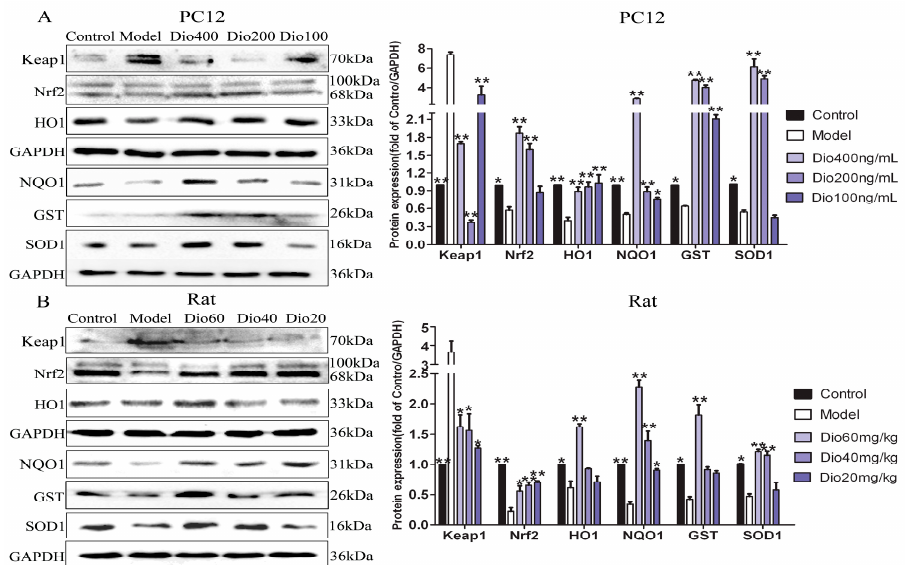
Figure 7. Dioscin-adjusted Nrf2/ARE signal pathway. ( A ) Effects of dioscin on the expression levels of keap1, Nrf2, HO-1, NQO1, GST and SOD1 in PC12 cells treated by H 2 O 2 . ( B ) Effects of dioscin on the expression levels of keap1, Nrf2, HO-1, NQO1, GST and SOD1 in brain tissue of aging rats. Data are presented as the mean ±SD (n = 3). * p < 0.05 and ** p < 0.01 compared with model groups.